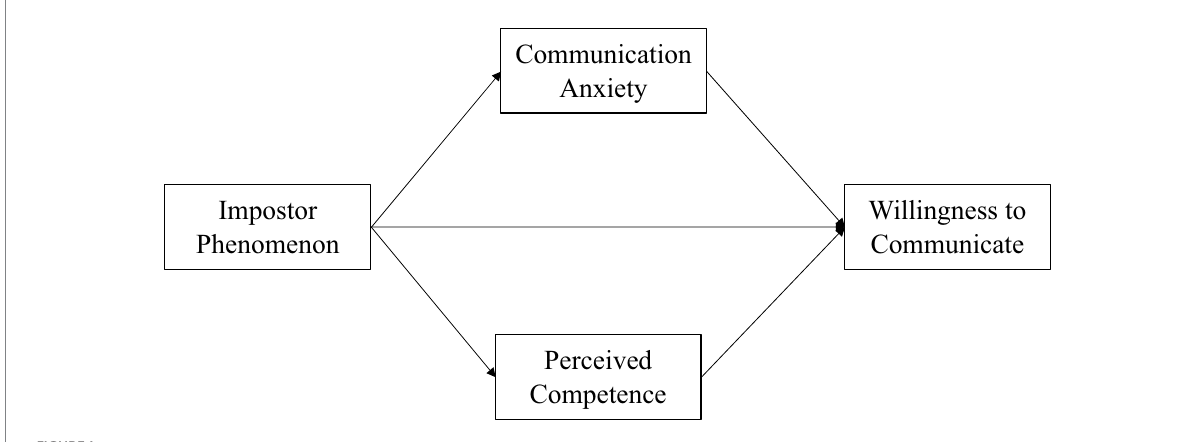
FIGURE 1 Parallel mediation model testing the association between the Impostor Phenomenon and willingness to communicate under consideration of perceived competence and communication